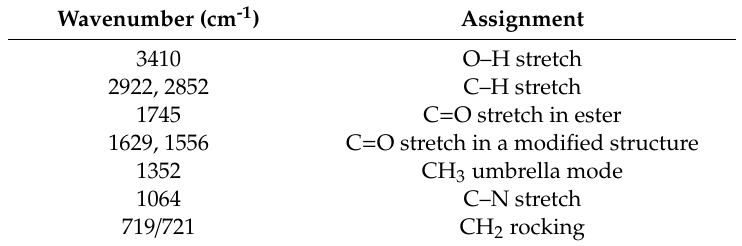
Table 2. The peaks and their assignments in spectra for unmodified and modified palm stearin.